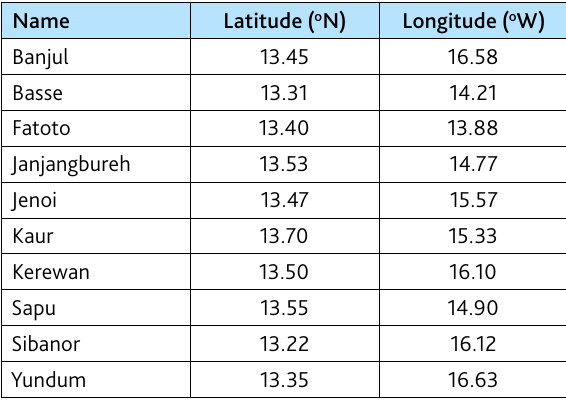
Table 1. Location of the Meteorological Stations